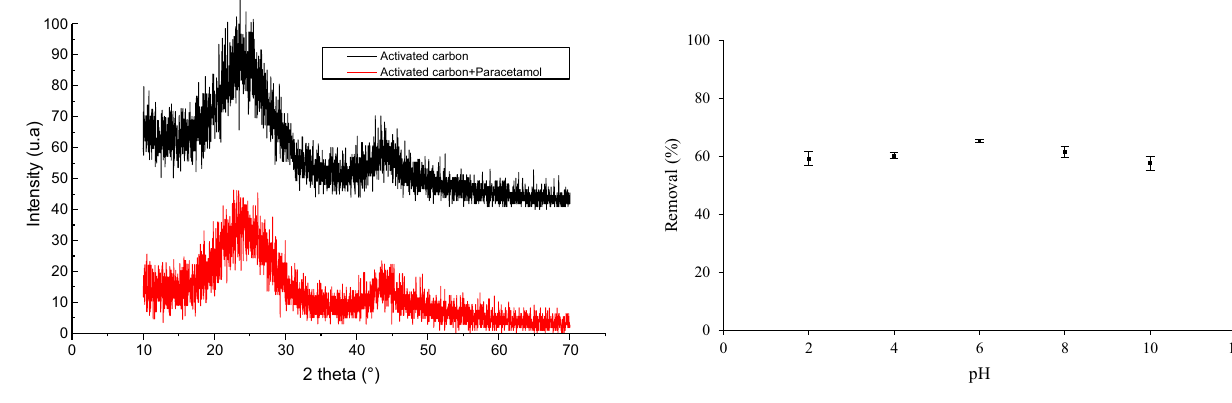
Fig. 1 X-ray patterns of solid before and after adsorption Fig. 2 Effect of pH on paracetamol